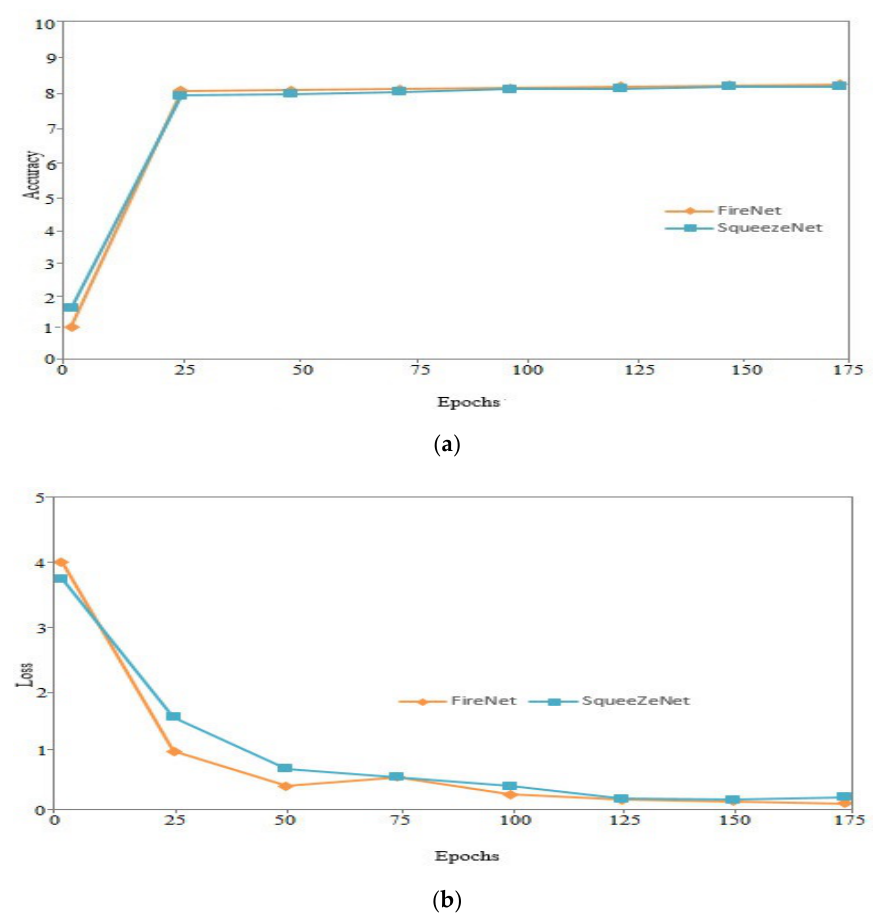
Figure 7. Training progress of our proposed FireNet model and SqueezeNet. ( a ) the performance during the training phase. ( b ) the performance during the training loss phase.